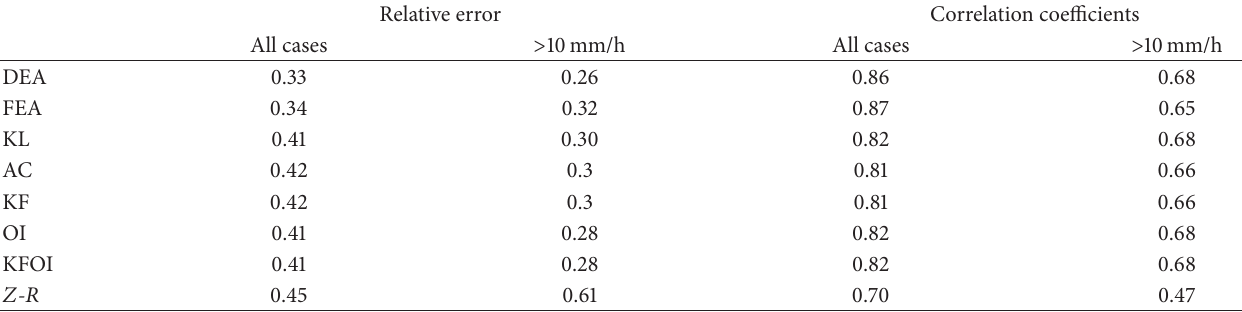
Table 2: Relative errors and correlation coefficients of QPE and rain gauge from June 30 to July 9,